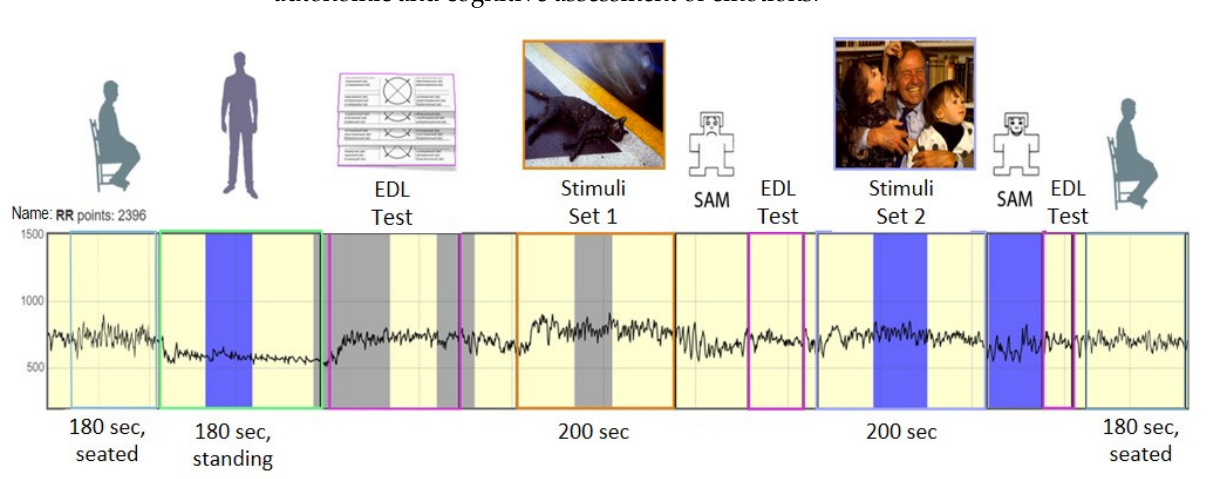
Figure 6. Basic experiment design.